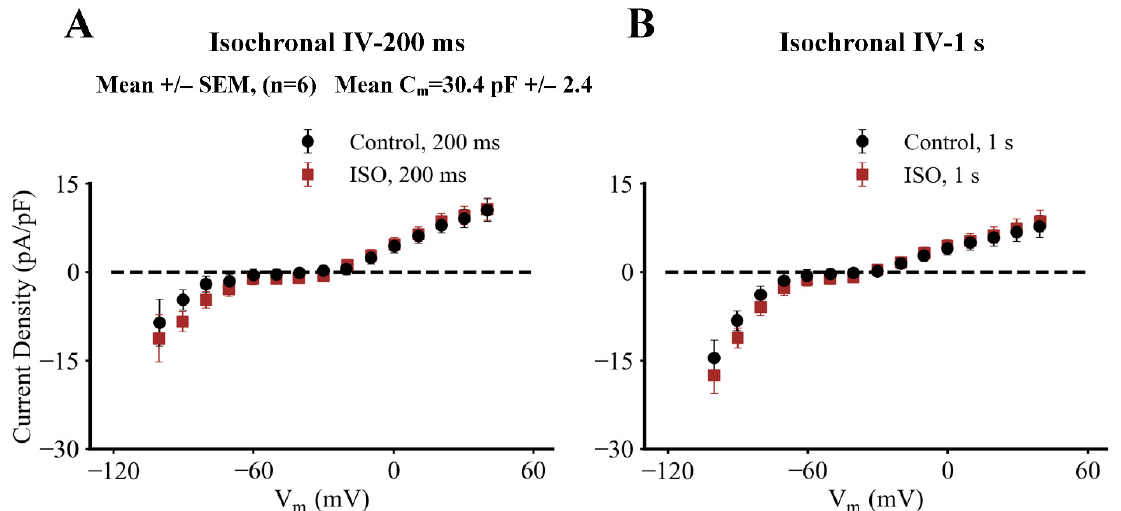
Figure 3. Isochronal current-voltage (I–V) relations corresponding to the families of currents shown in Figure 2. ( A ) The two current-voltage (I–V) relationships were obtained by measuring the maximum outward or inward currents at the end of each 200 ms rectangular voltage clamp step. ( B ) The two superimposed I–V curves are analogous to those on the left except that each data point was obtained following a 1 s rectangular voltage step. Each data set is expressed in terms of current density based on the mean capacitance of each pacemaker myocyte in this series measuring 30.4 pF +/ − 2.4, ( n = 6). Note that in response to the 200 ms clamp steps ISO at 10 nM (red data points) may produce a small increase in inward current in the membrane potential range between approximately − 20 to − 50 mV; and that this ISO-induced inward current is more clearly observed at strongly hyperpolarized membrane potentials between − 80 and − 100 mV. The two superimposed I–V curves in the right panel also provide an indication that relatively large and long (1 s) depolarizations or hyperpolarizations can increase transmembrane current in the presence of 10 nM ISO.